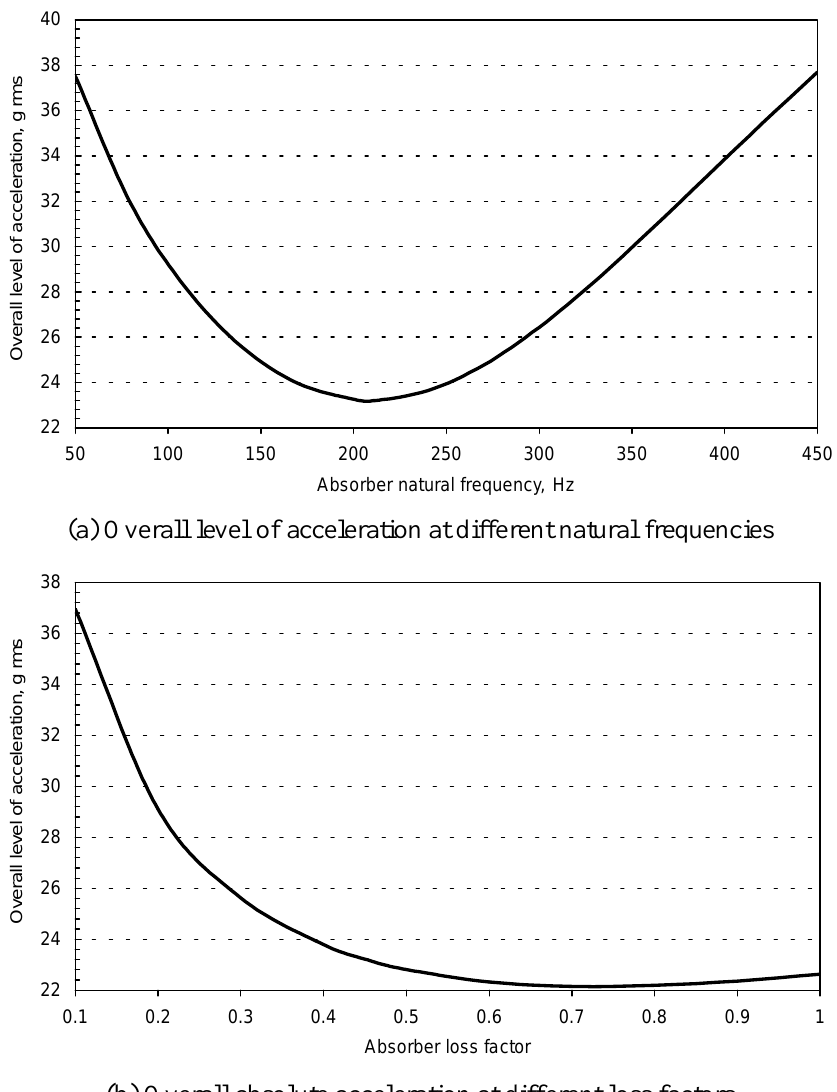
Fig. 6. Performance of the dynamic absorber at different natural frequencies and loss factors. a) Overall level of acceleration at different natural frequencies; b) Overall absolute acceleration at different loss factors. we obtain, for example, that at this particular